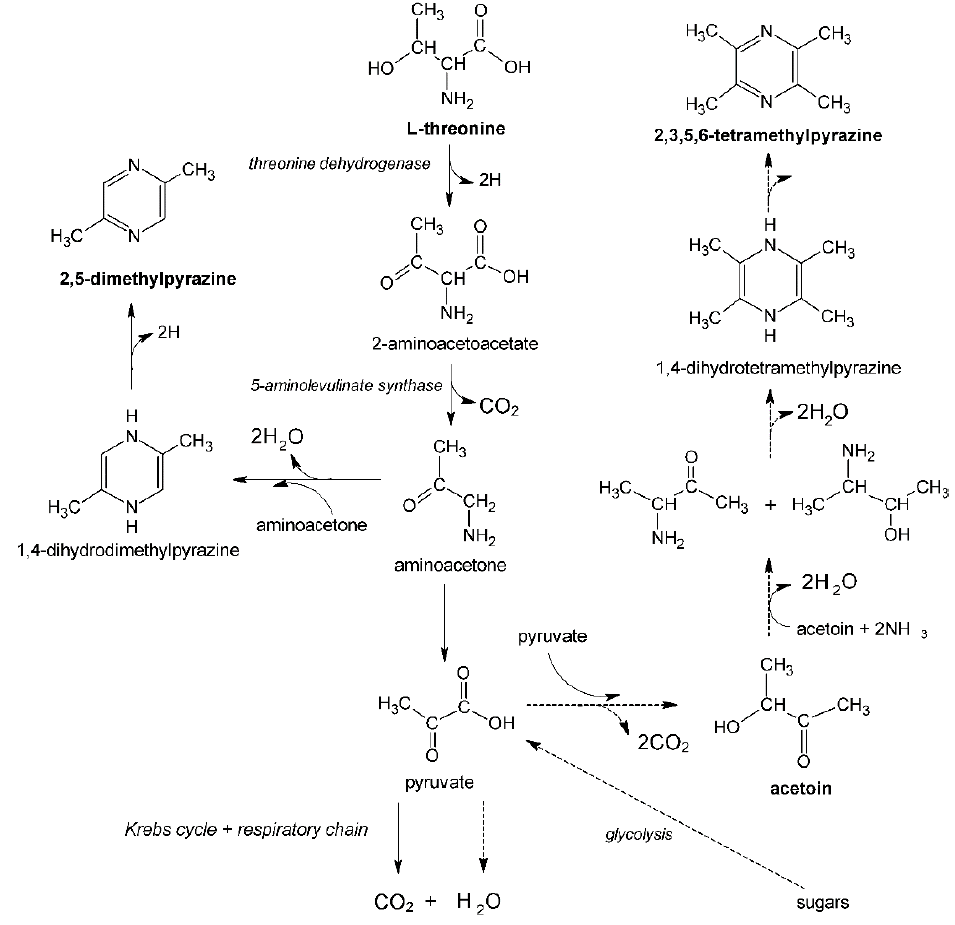
Figure 2. Metabolic pathways for 2,5-dimethylpyrazine and 2,3,5,6-tetramethylprazine synthesis [10].